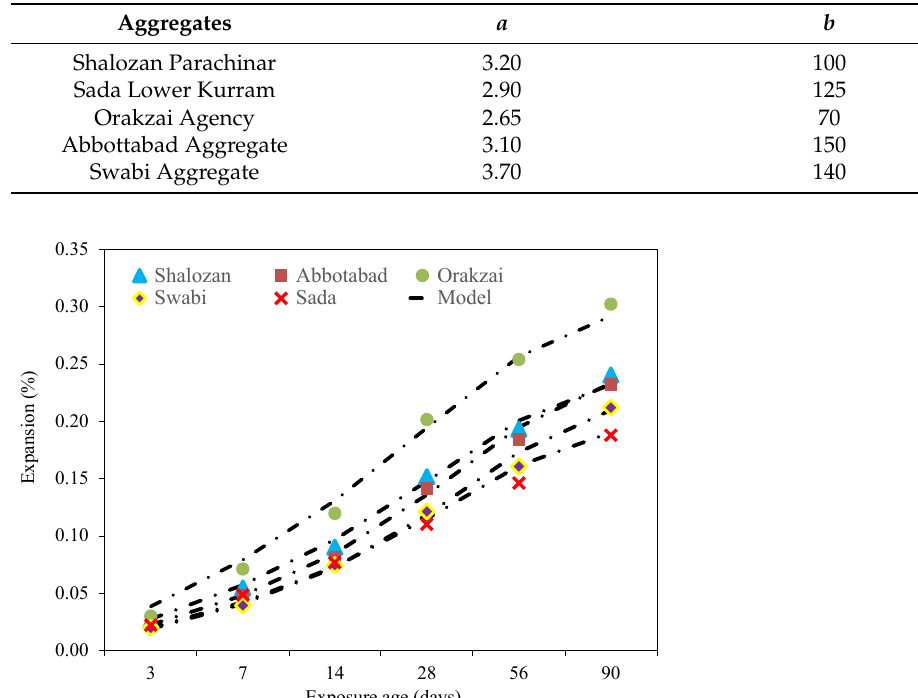
Table 7. Regression parameters for the tested aggregates.